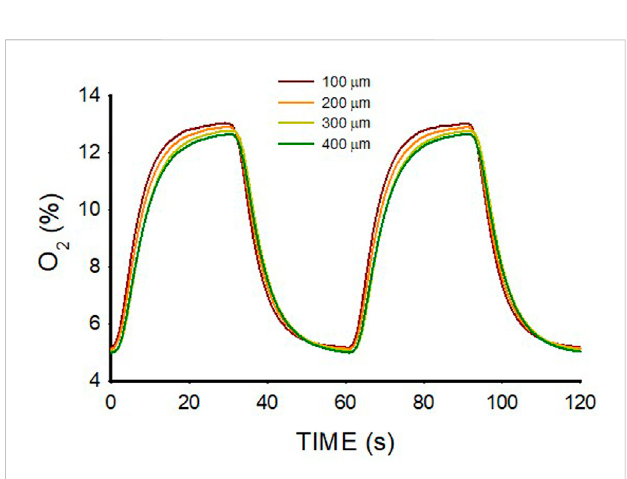
FIGURE 5 Oxygen concentration measured at different positions ( z ; Figure 2A) within a lung extracellular matrix hydrogel of thickness W = 500 μ m when the intermittent air circulating beneath the membrane was 15% O 2 for 30 s and 5% O 2 for 30 s.